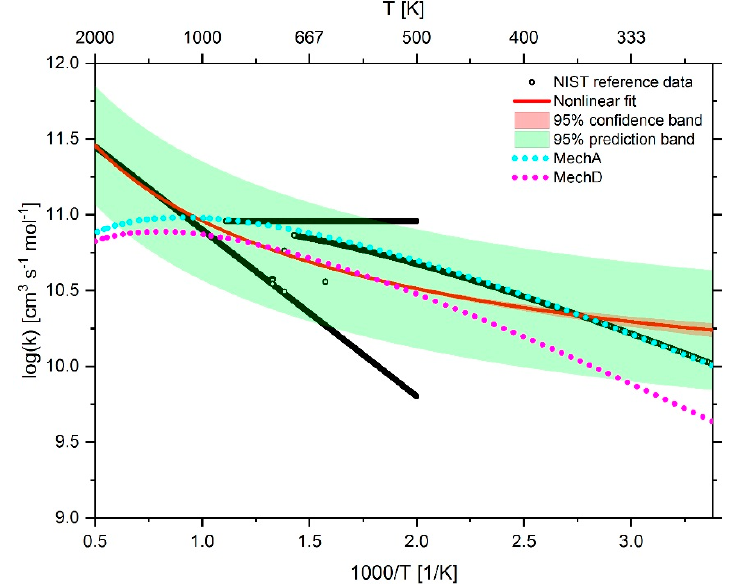
Figure 14. Comparison of the reaction rate coe ffi cient of reaction 244 ( n -C 3 H 7 + O 2 ↔ C 3 H 6 + HO 2 ) of MechA and MechD as well as the fitted rate coe ffi cient using reference data from the NIST database.